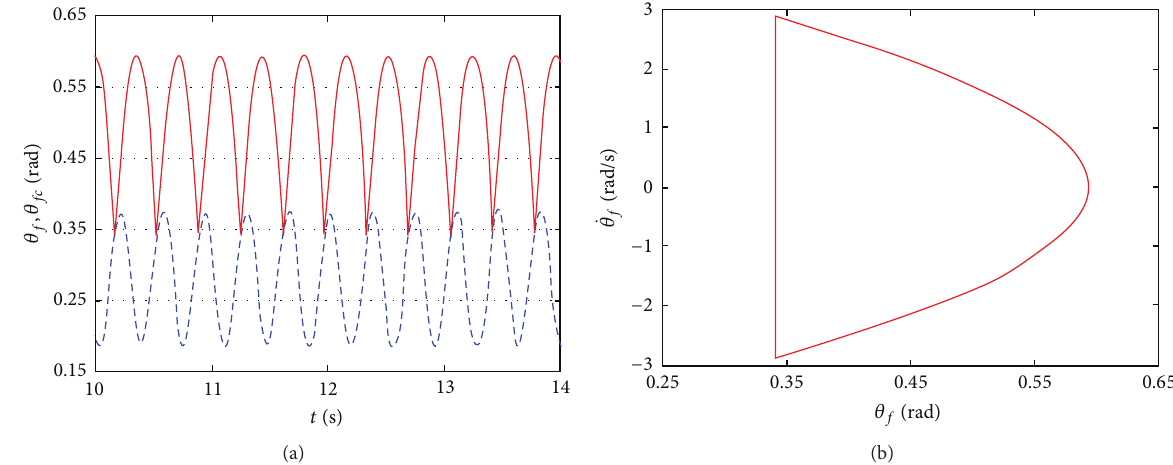
Figure 6: 𝑃(1,1) motion when 𝜔 = 17.4 rad/s: (a) time history of 𝜃 𝑓 (solid line) and 𝜃 𝑓𝑐 (dashed line) and (b) phase diagram.